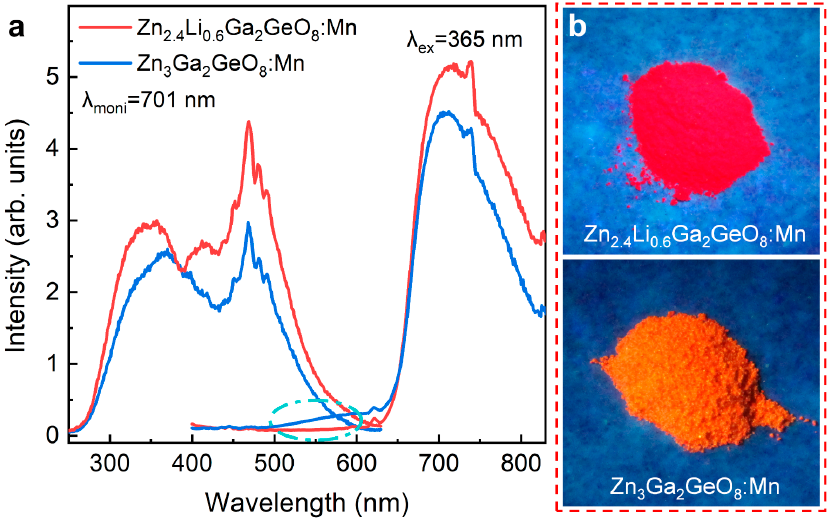
Figure 5. PLE and PL spectra and the corresponding digital PL images of Zn 2.4 Li 0.6 Ga 2 GeO 8 :Mn and Zn 3 Ga 2 GeO 8 :Mn phosphors synthesized by solid-state reaction. ( a ) PLE spectra monitored at 701 nm and PL spectra under 365 nm UV lamp excitation; ( b ) Digital PL photographs under 365 nm irradiation. The camera parameters are manual/ISO 3200/1 s. The slight difference in PL spectra can be seen in the cyan dash dot ellipse.